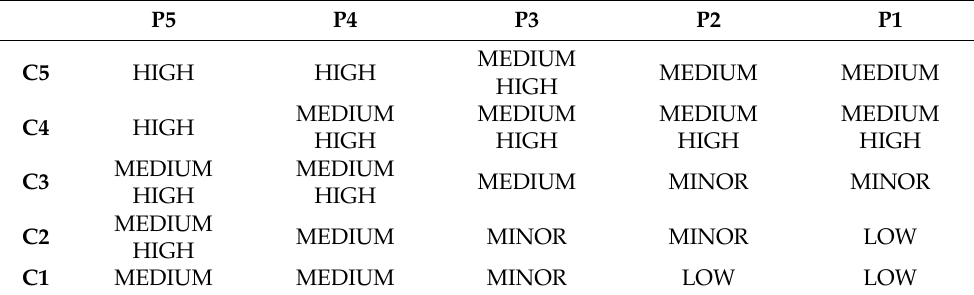
Table 7. Matrix of the calculating level of risk.